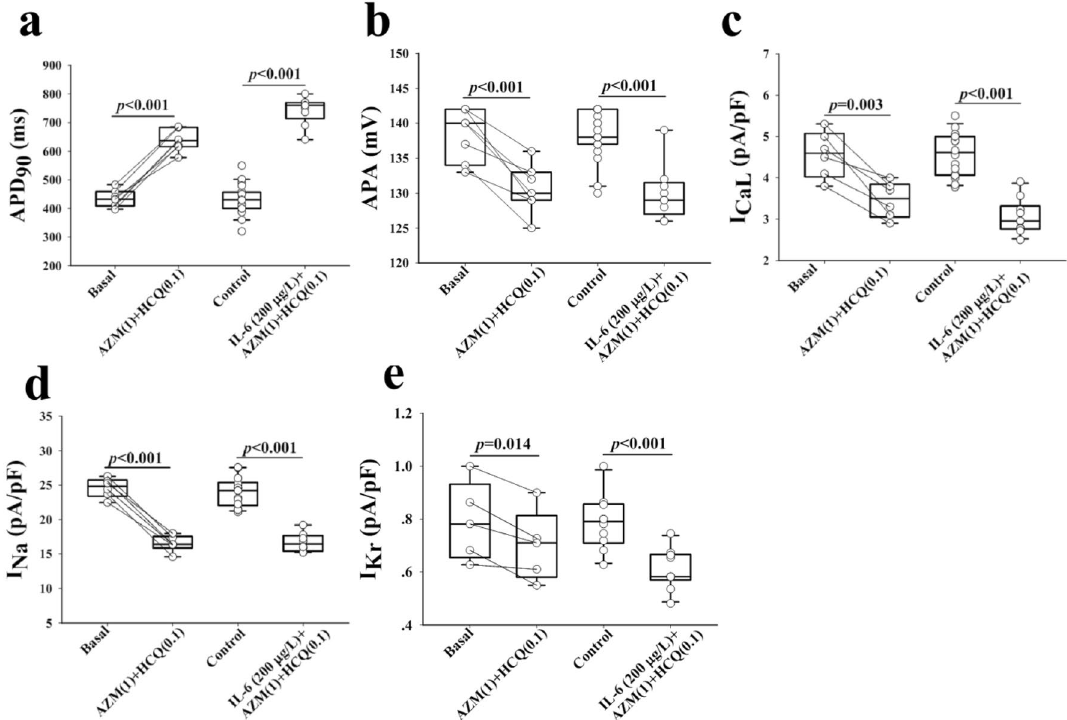
Figure 6. Impact of azithromycin and hydroxychloroquine with and without interleukin-6 on action potential and key ion channels in guinea pig ventricular myocytes. APD 90 ( a ), AP amplitude (APA, b ), I CaL ( c ) I Na ( d ) and I Kr ( e ) data from two groups of guinea pig myocytes before (basal) and after administrations of AZM(1) + HCQ(0.1); and the other control group without IL-6 and the treated group with IL-6 (200 μg/L), AZM(1) and HQC(0.1). AZM(1) = 41.5 mg/L; HCQ(0.5) = 24.9 mg/L. Paired t-test was used within the same group before (basal) and with (AZM + HCQ). Unpaired t-test was used between control group and the group treated with IL-6 + AZM + HCQ. p values shown are comparison to basal